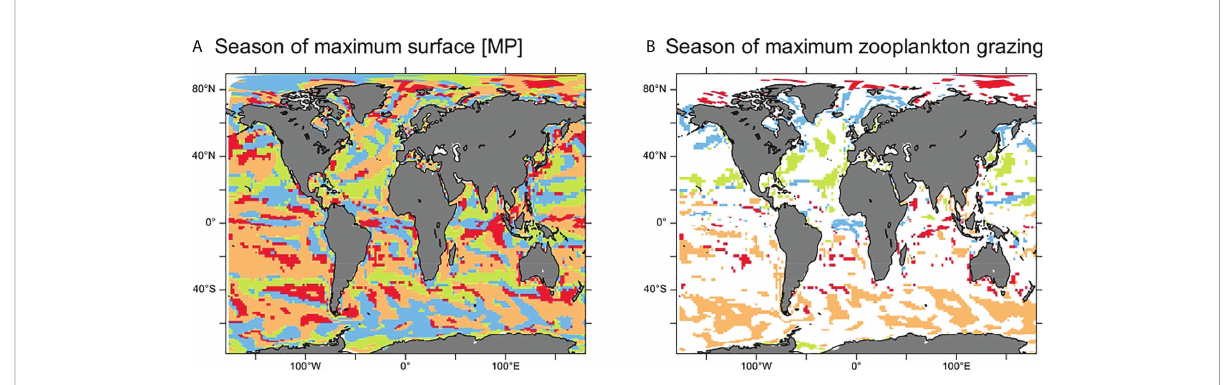
FIGURE 7 Maps identifying the timing of seasonal maximum in surface (0 – 100 m) MP concentration (A) and zooplankton grazing (B) . On panel B, only the regions where the seasonal maximum in MP concentration and zooplankton grazing co-occur are fi lled. Regions colored in orange indicate